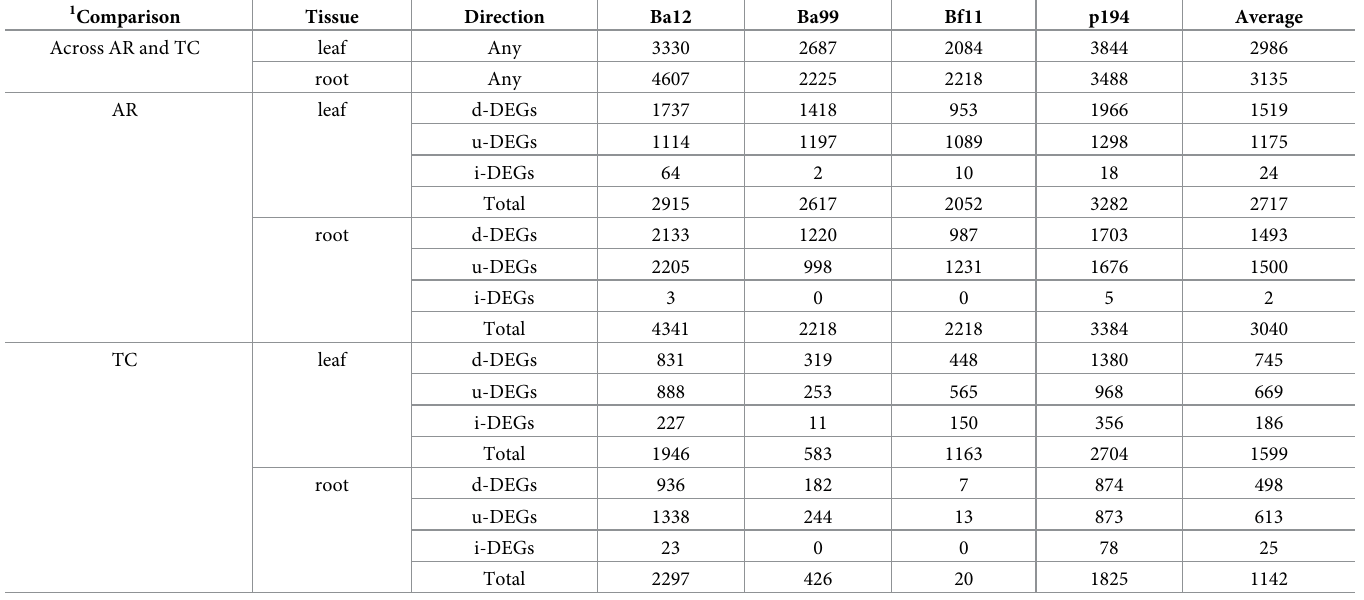
Table 1. The numbers of up (u-), down (d-) or inconsistent (i-) differentially expressed genes (DEGs) in the leaf and root of the 4 genotypes according to compari- son type. 1